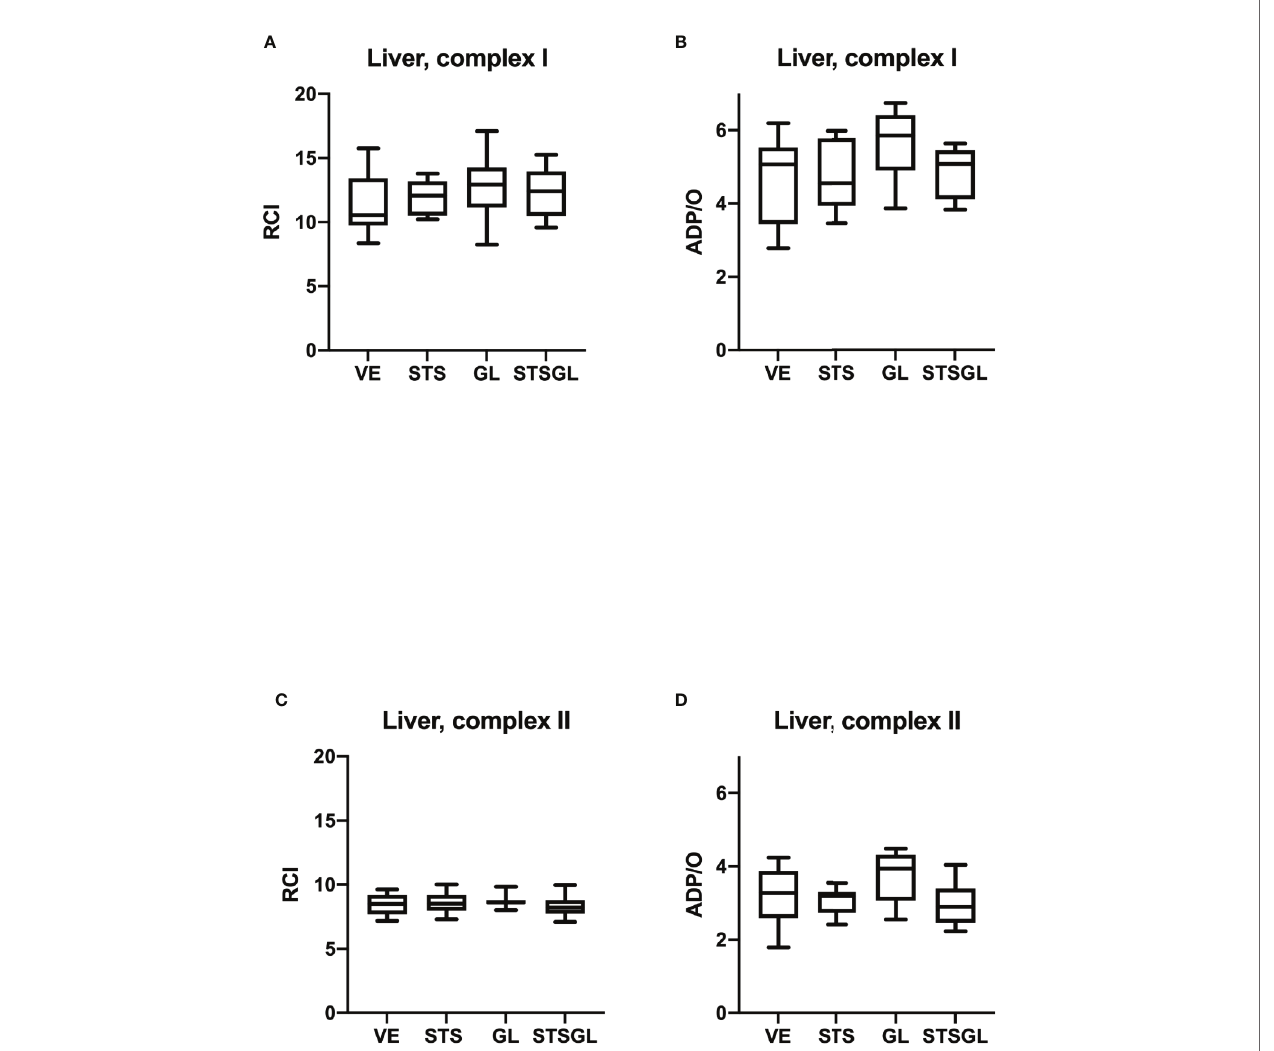
FIGURE 5 | Hepatic mitochondrial function in septic animals. Effect of sodium thiosulfate (STS), glibenclamide (GL) and sodium thiosulfate/glibenclamide(STSGL) compared to control (vehicle: VE) on mitochondrial function of hepatic tissue homogenates from septic rats: respiratory control index (RCI) for complex I (A) and complex II (C) and ADP/ratio for complex I (B) and complex II (D) . Data are presented as Box-Whisker-Plots presenting median, interquartile range, minimum and maximum value,